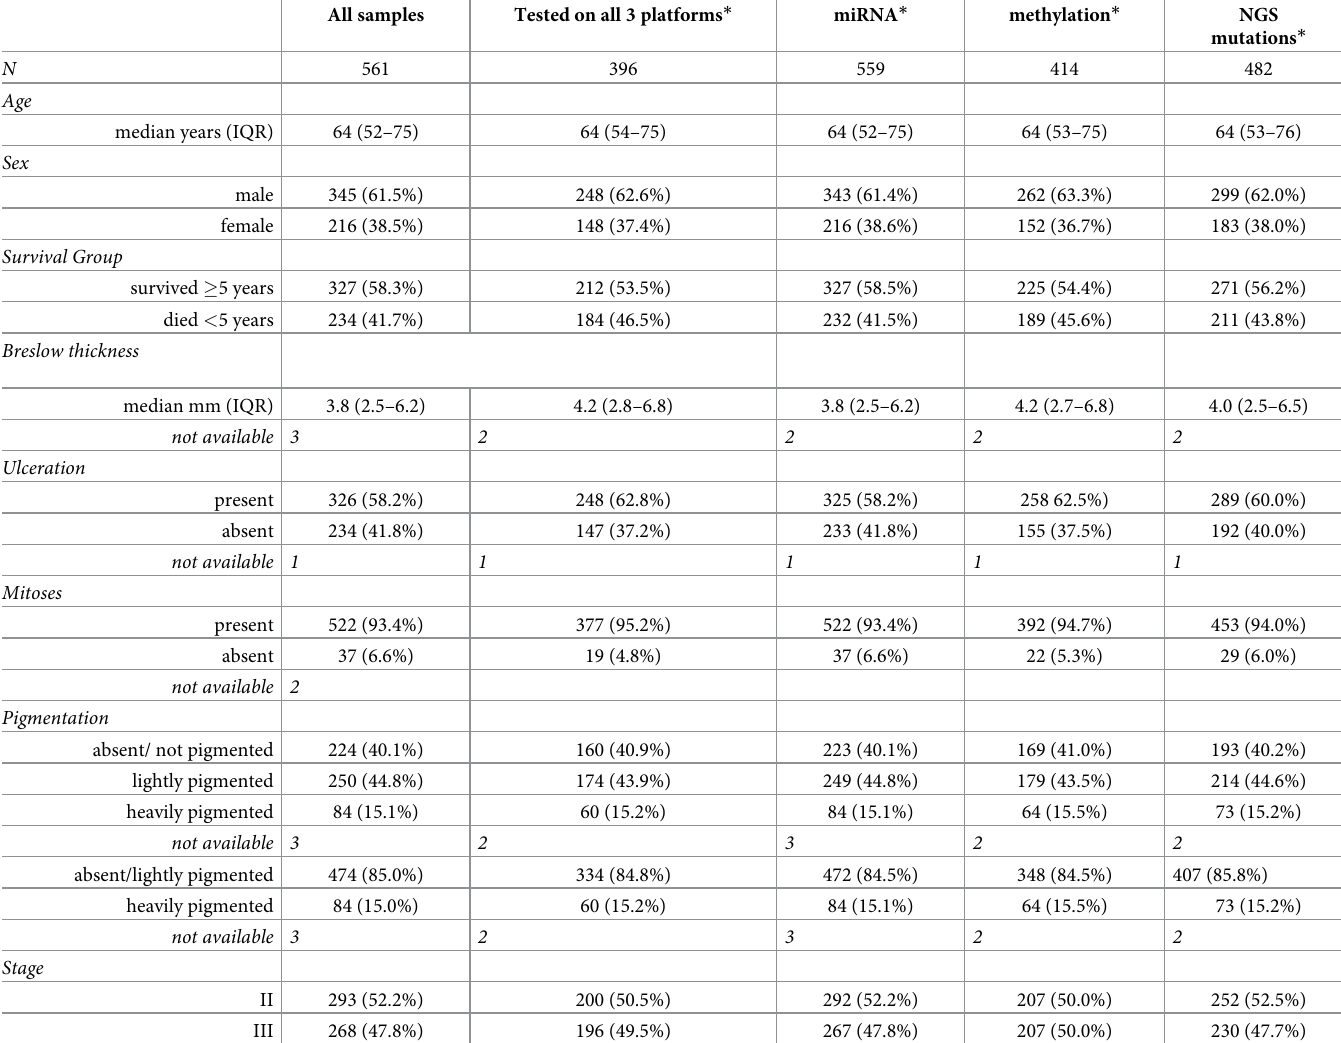
Table 4. Characteristics of participants and their melanomas for cases and controls with available full histopathology review and with samples allocated for testing, by miRNA, methylation, and mutation profiling platforms. All